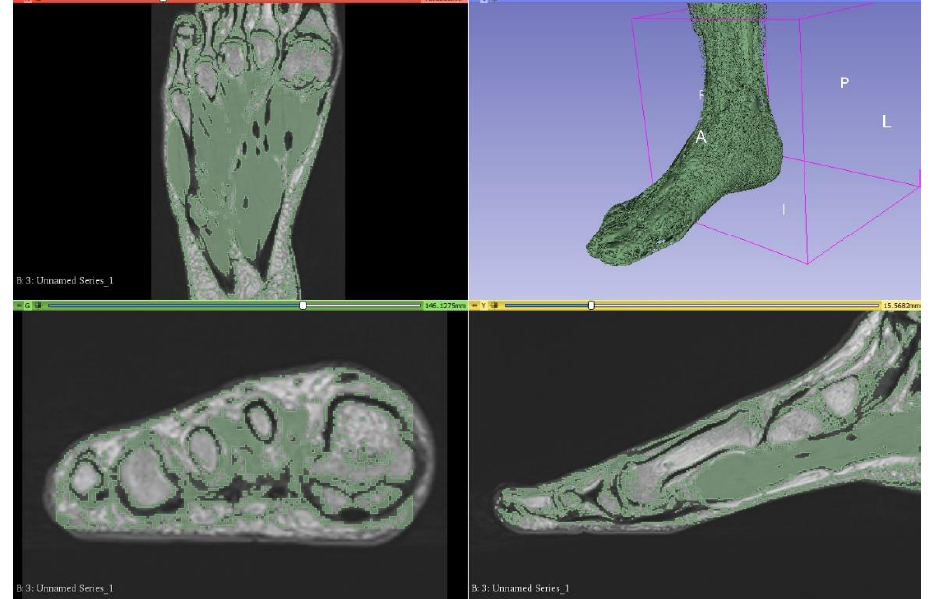
Figure 2. Attempted segmentation of musculature in 3D Slicer via the thresholding function, which proved ineffective. This is as viewed on the 3D Slicer observation panel, which is organised into axial ( upper left ), 3D ( upper right ), coronal ( lower left ), and sagittal views ( lower right ). A—anterior, I—inferior, L—left, P—posterior, R—right.